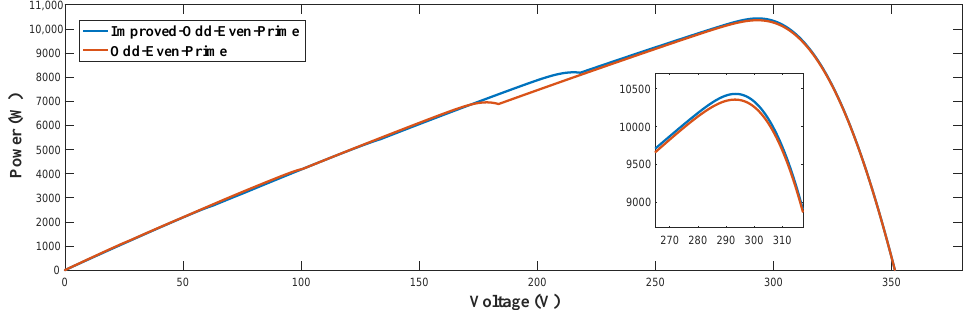
Figure 17. Voltage–power characteristics of 8 × 9 PV array for case-1 (Top-Left) PSC.